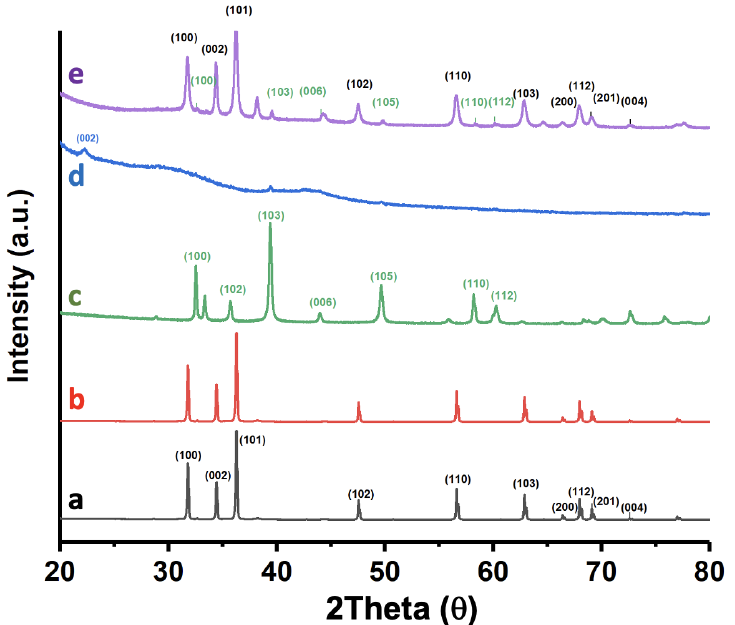
Figure 4. XRD patterns of ZnONPs ( a ); 5%Au@ZnONPs ( b ); MoS 2 ( c ); rGO ( d ); and 5%Au@ZnONPs- 3%MoS 2 -1%rGO ( e ).